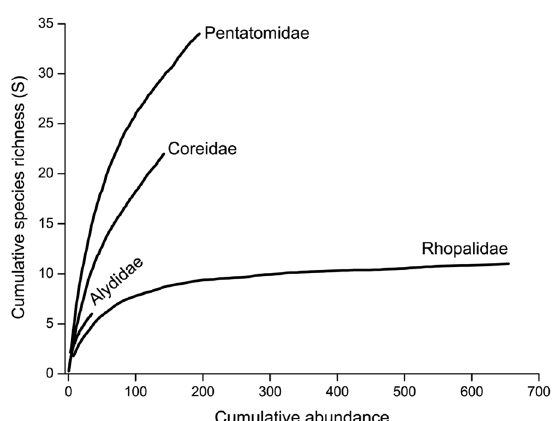
Figure 3 - Rank-abundance curves and dominant species of the bugs families studied in Parque Provincial